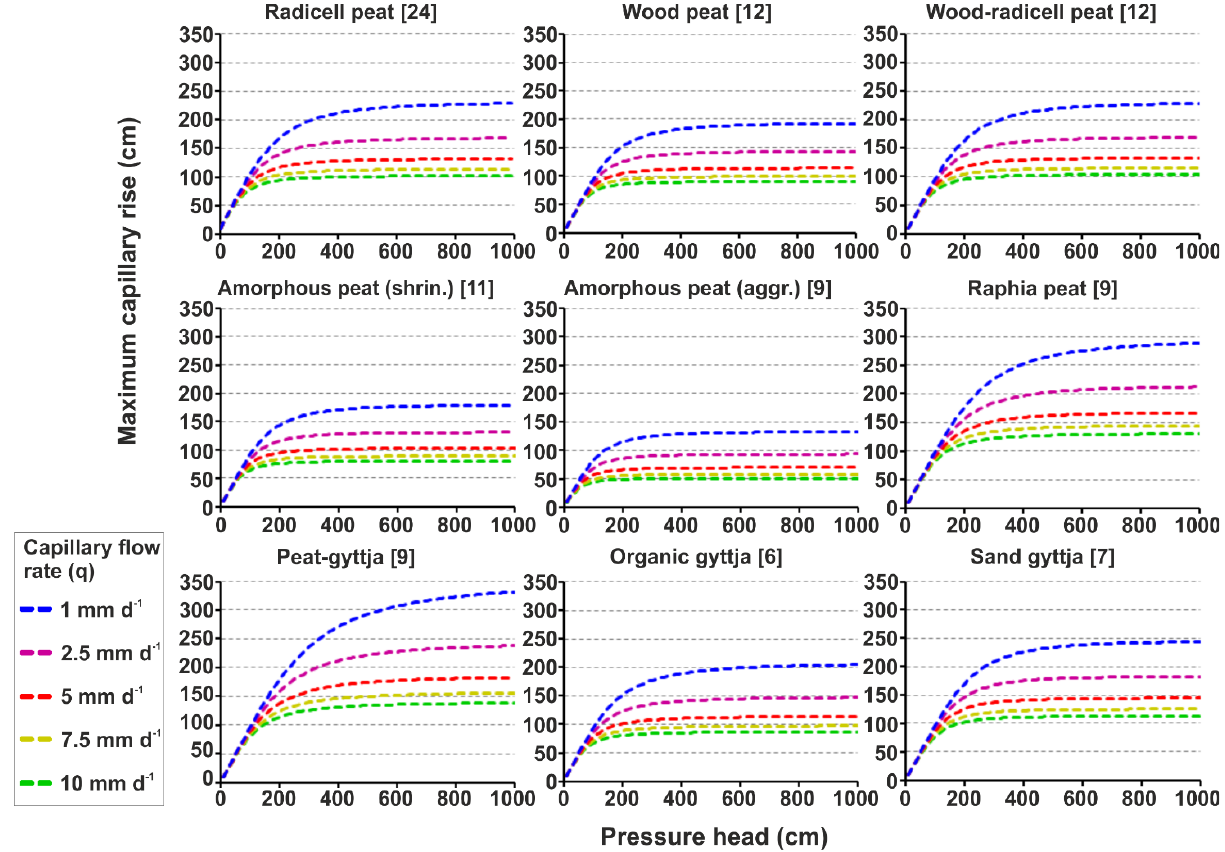
Figure 8. Maximum capillary rise for different substrates. Pressure head: 100 cm = pF 2; 1000 cm = pF